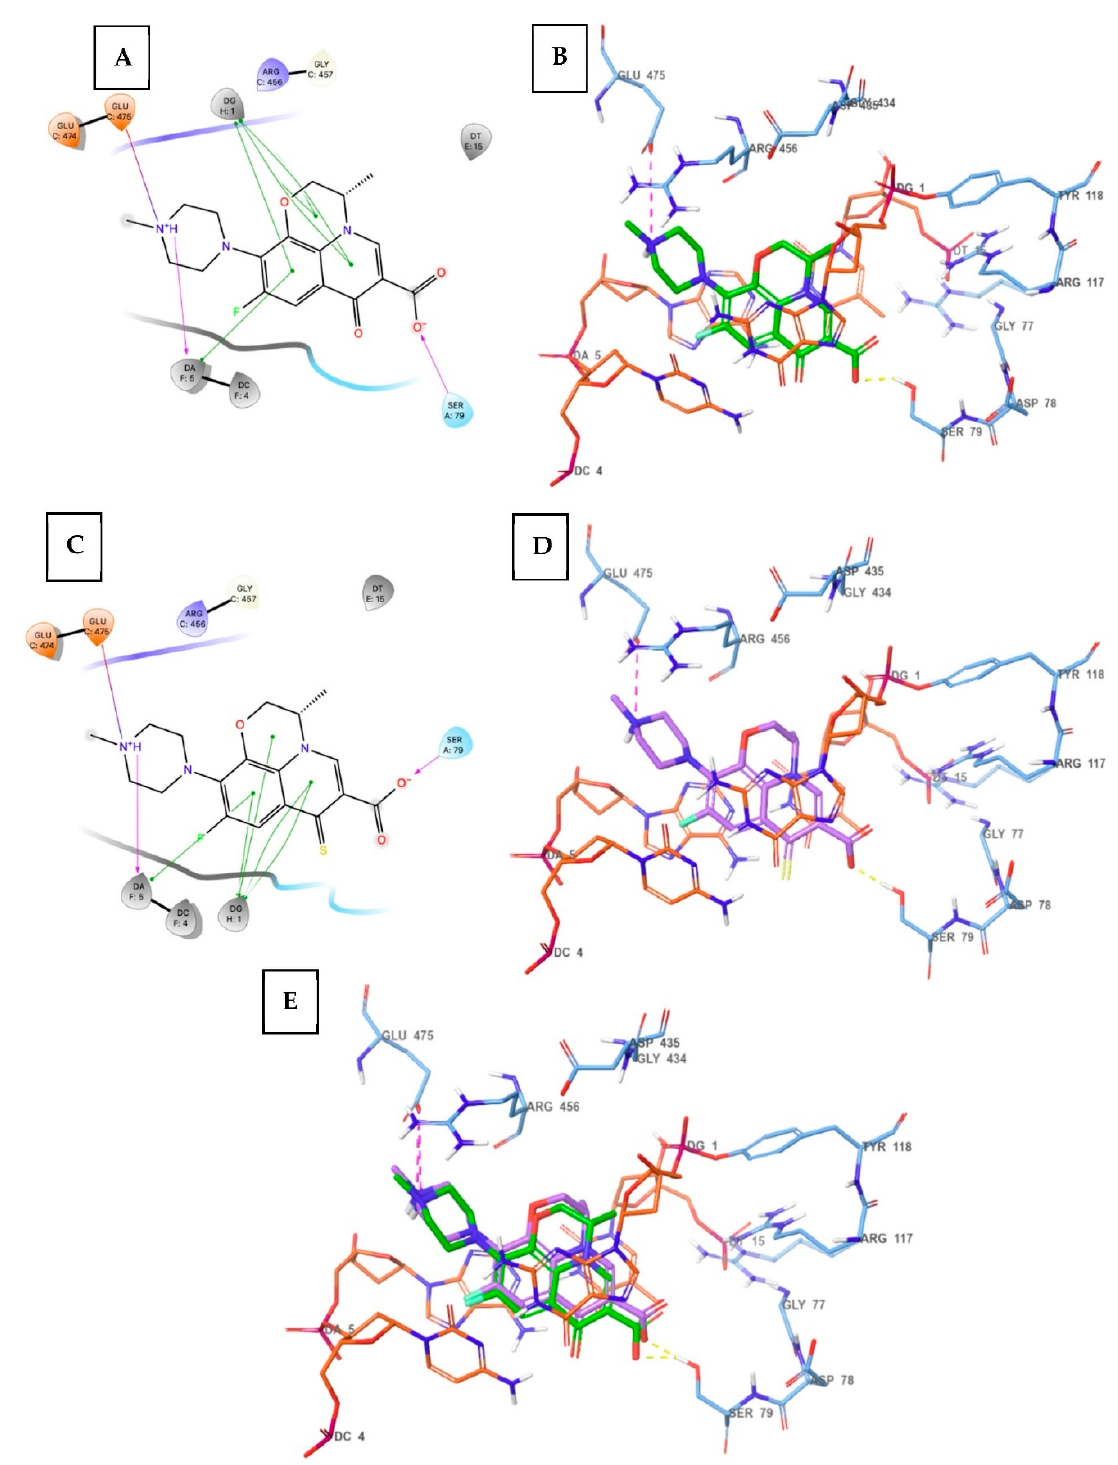
Figure 4. 2D (panel ( A )) and 3D (panel ( B )) crystallographic binding mode of levofloxacin (green) within the binding site of S. pneumoniae ; 2D (panel ( C )) and 3D (panel ( D )) docking pose of compound 3 (purple) within the binding site; and (panel ( E )) superposition of levofloxacin and compound 3 within the binding site (residue atoms view).